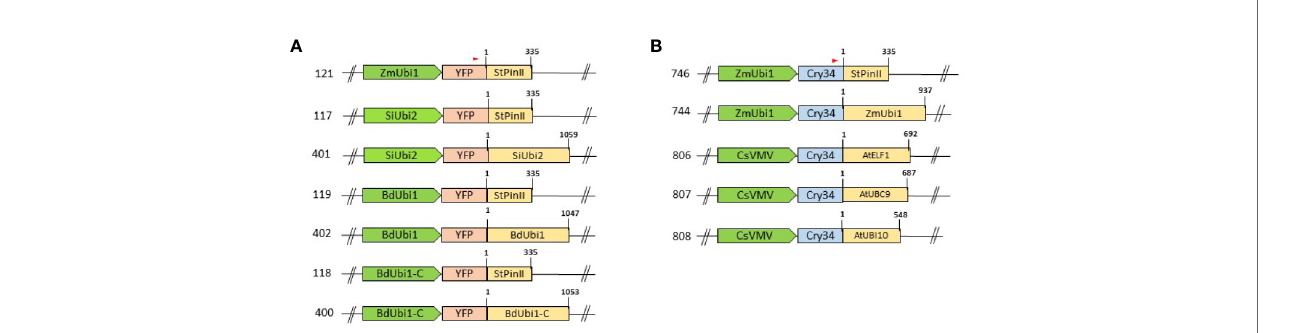
FIGURE 1 | Schematic representation of assembled T-DNA cassettes: promoters and TTs are depicted as green arrows and yellow boxes, respectively. Distinct RE combinations were tested using the yfp (A) and cry34Ab1 (B) reporter genes as depicted by pink and blue boxes, respectively. The T-DNA backbone and the selection marker , aad-1 , present at the 3 ′ end of the cassettes are not shown in the schematic. The numbers on the left of the cassettes denote the construct numbers. The numbers on the top left of the TT boxes depict coordinates corresponding to the 3 ′ RACE sequencing data and that on the top right of the boxes denote the total length of the TTs. The red arrow on top of the reporter gene box displays the oligo position for 3 ′ RACE